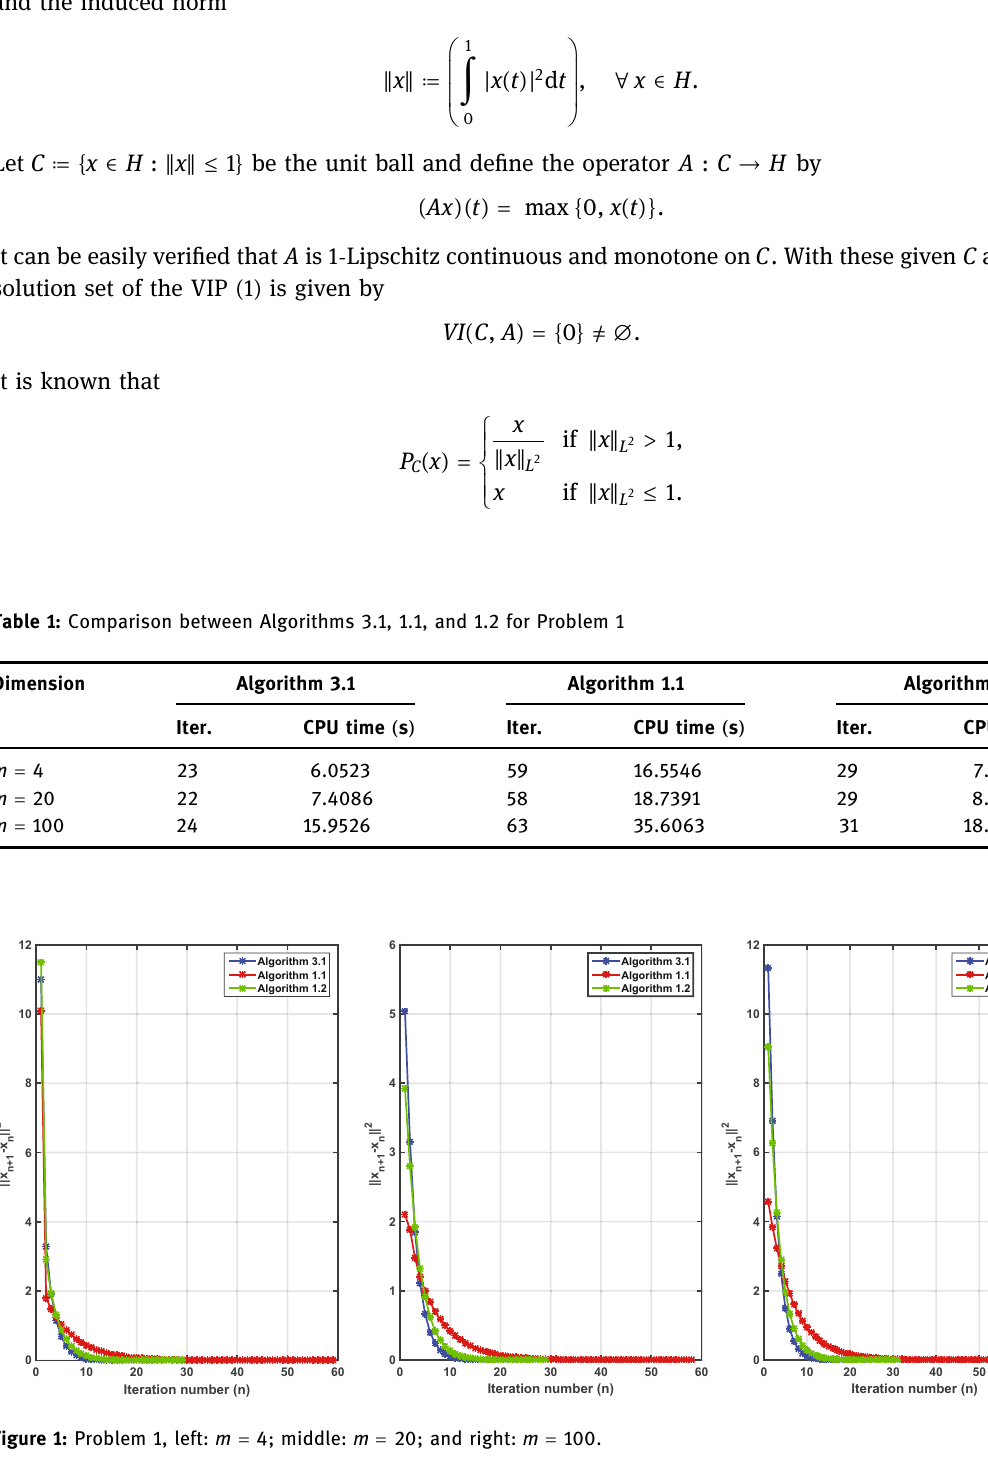
Figure 1: Problem 1, left: m 4 = ; middle: m 20 = ; and right: m 100 =